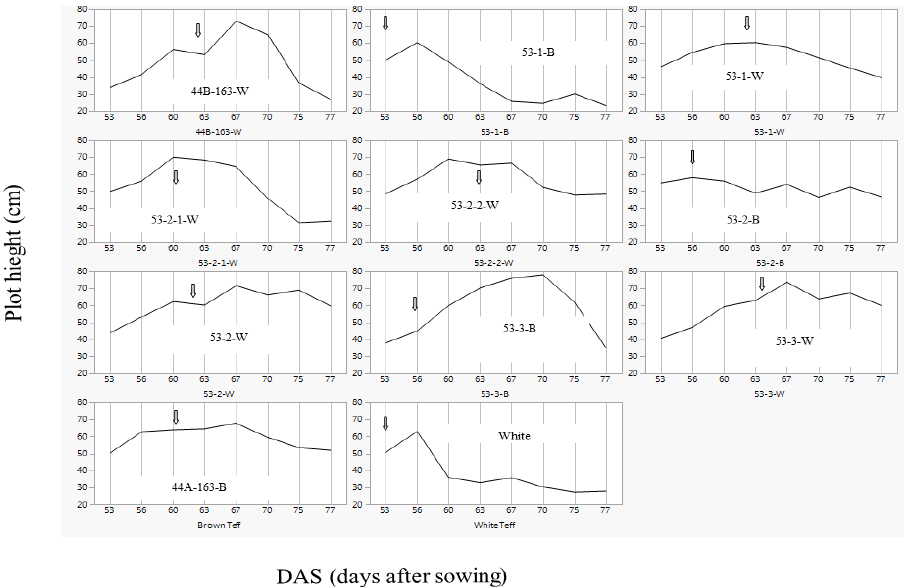
Figure 1. Plot height (cm) averaged for each genotype as a function of days after sawing (DAS). The arrows indicate averaged date of panicle emergence under field condition.